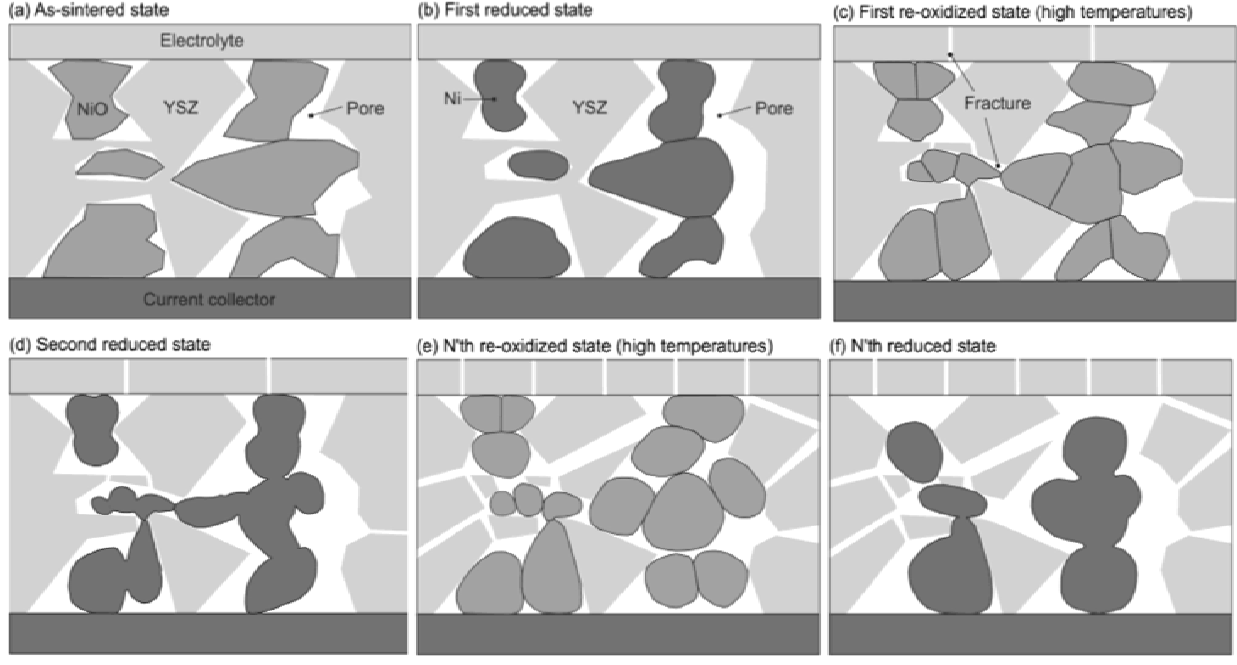
Figure 14. Model proposed by Klemensø et al. including the increase of Ni contact after a RedOx cycle due to breaking of the zirconia skeleton. Further RedOx cycles will create too much porosity to maintain sufficient conductivity [114].